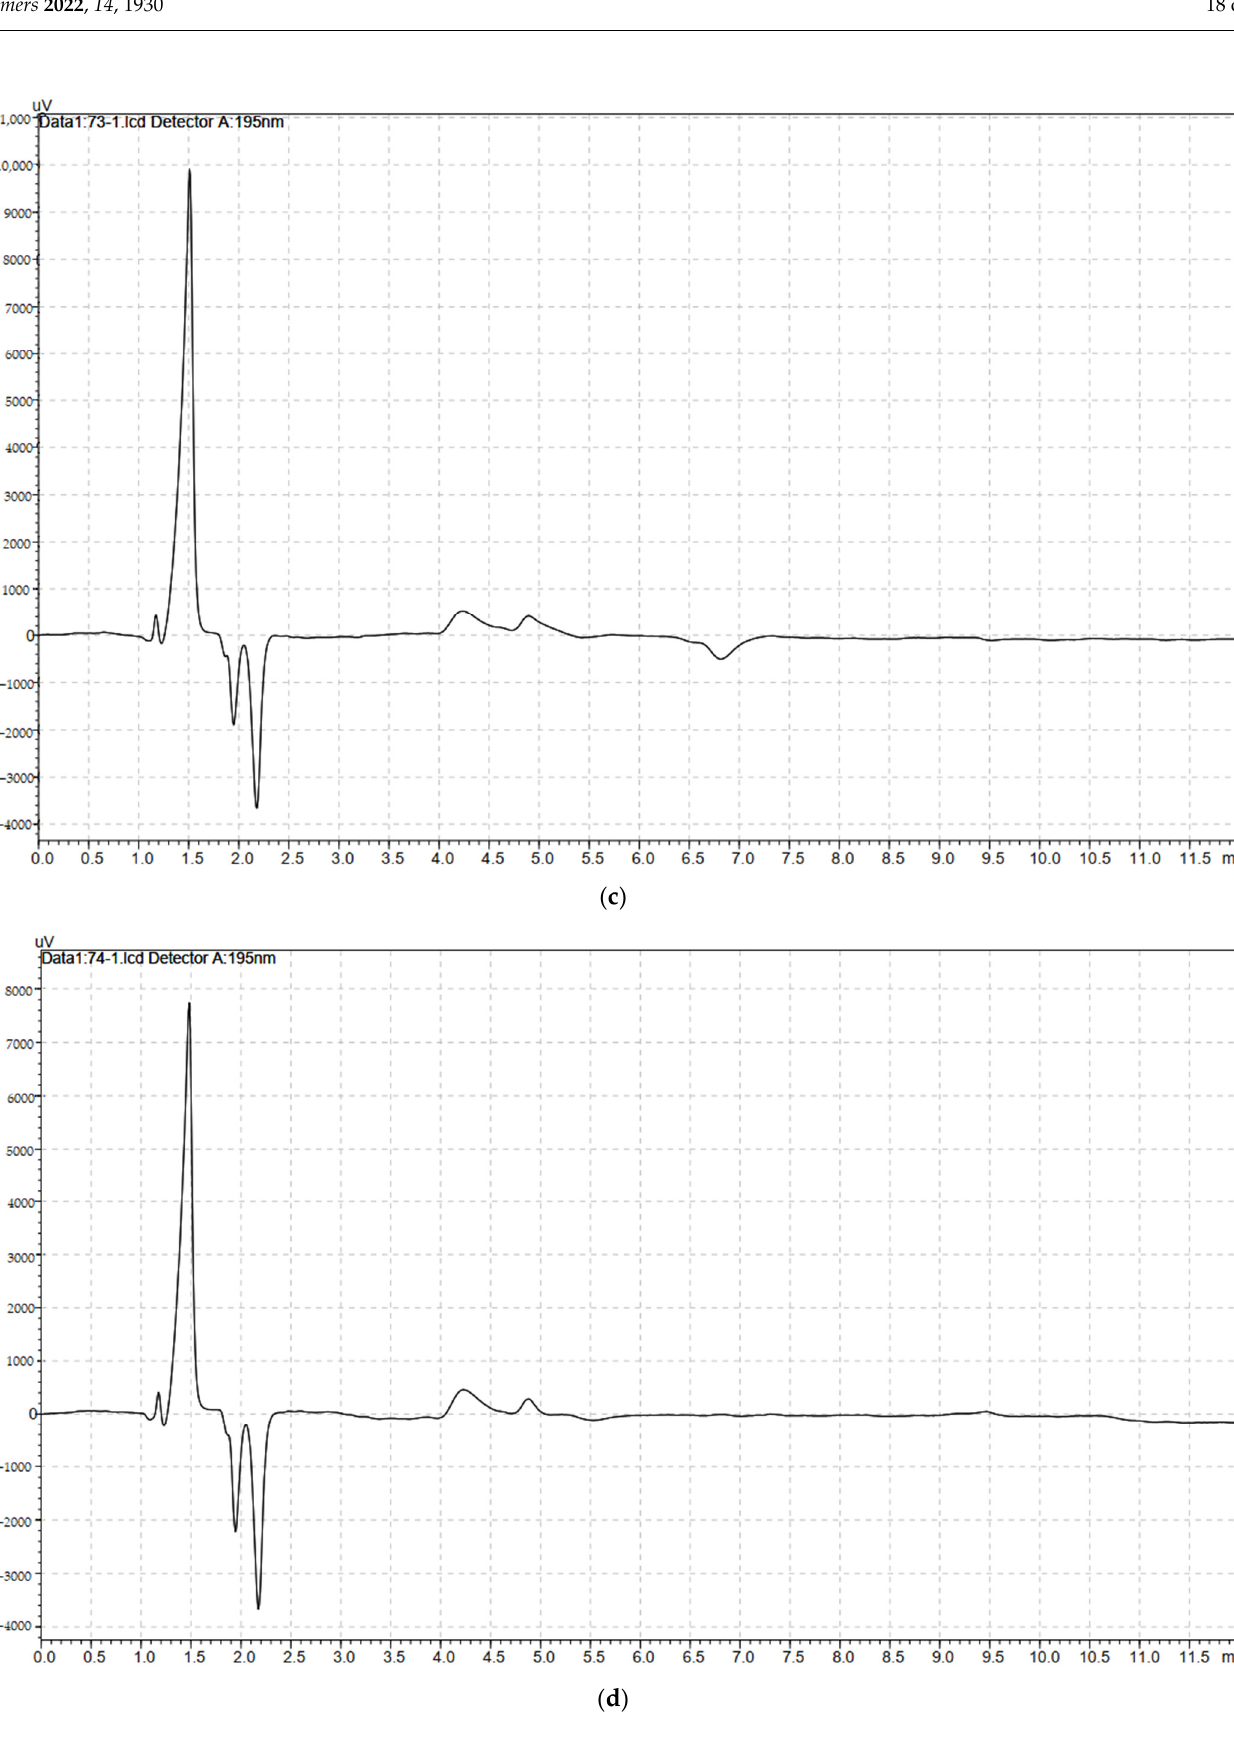
Figure 11. HPLC ( a ) standard nanocellulose (RSNFC), ( b ) nanocellulose GNFC/H 2 SO 4 , ( c ) GNFC/NaClO, and ( d ) GNFC/NaOH hydrolysis.